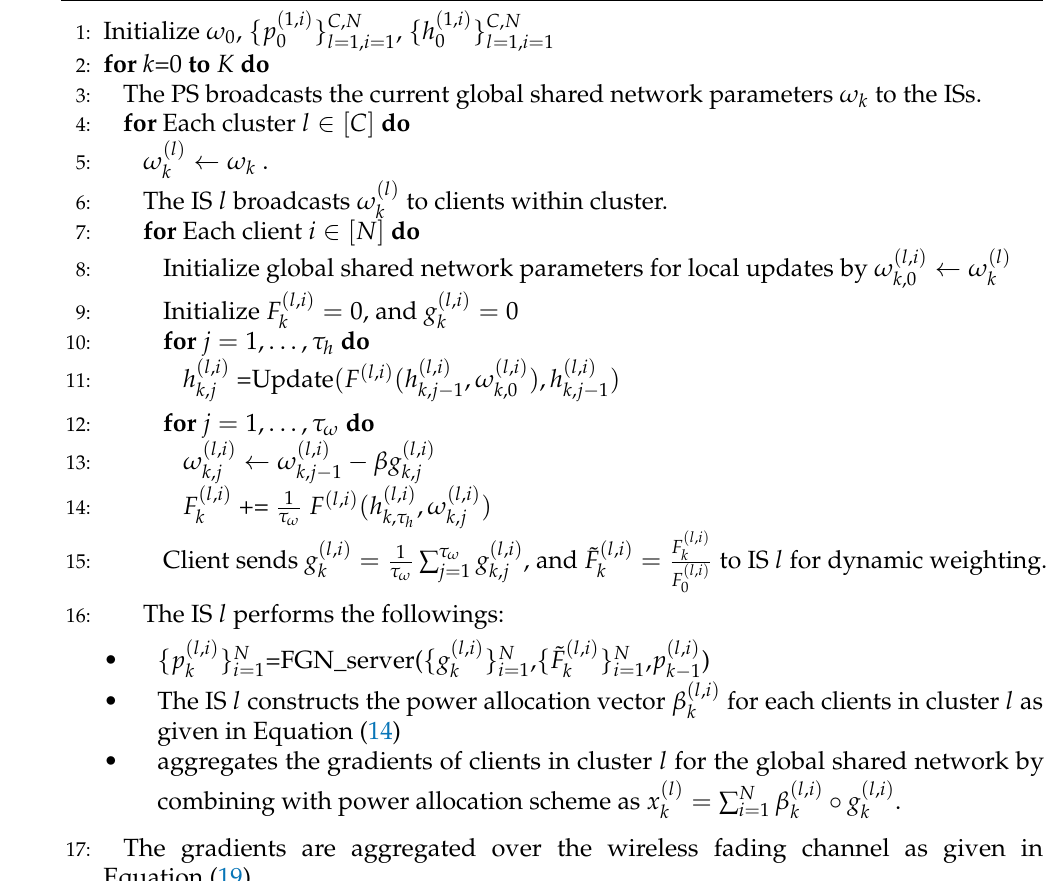
Algorithm 3 HOTA-FedGradNorm